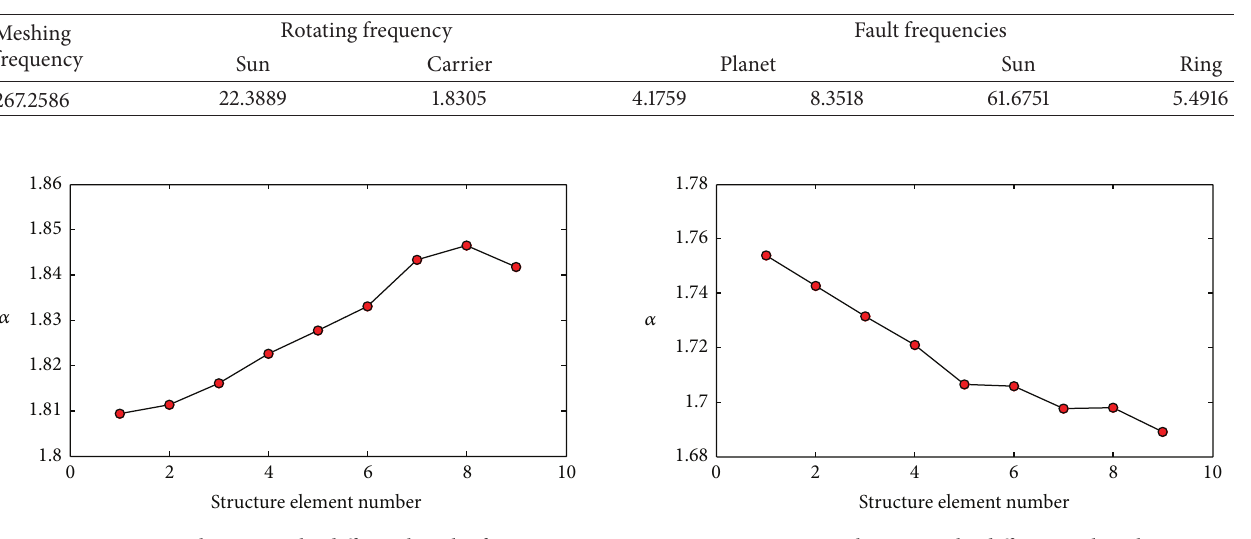
Figure 28: 𝛼 value versus the different length of SE.